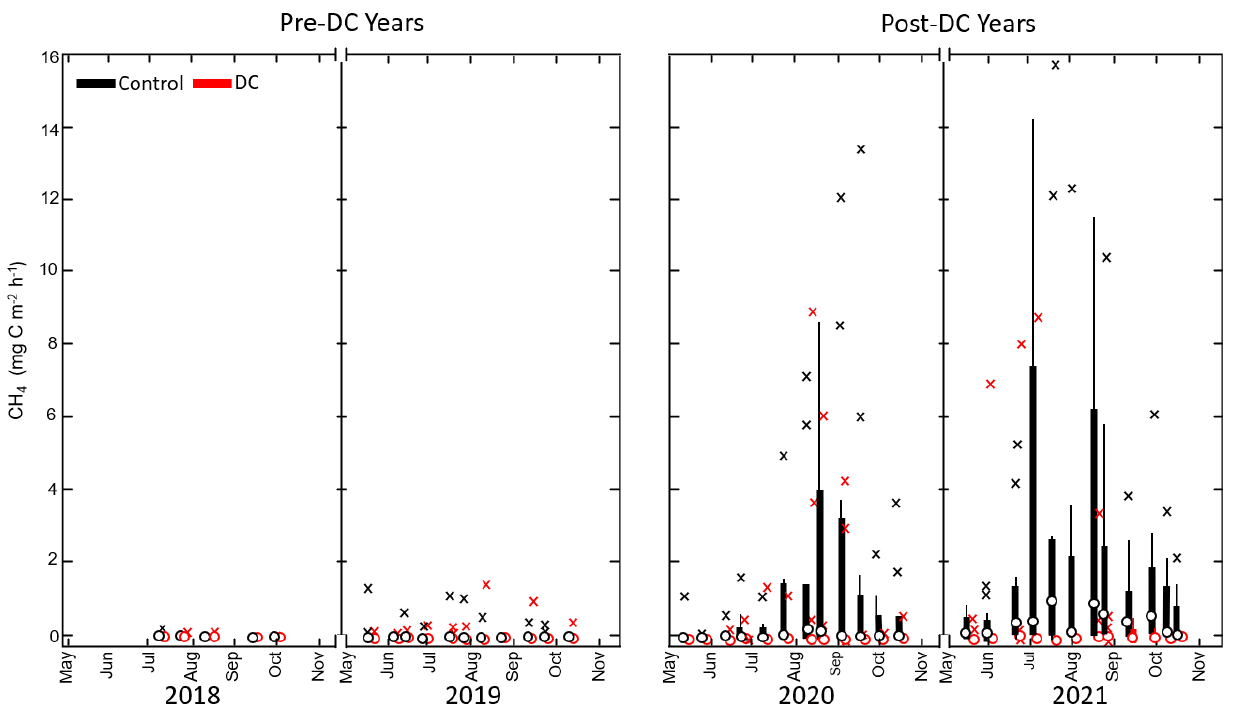
Figure 6. Seasonal variation of methane (CH 4 ) fluxes in control and ditch cleaning (DC) clear-cut areas during pre-DC (2018/19) and post-DC periods (2020/21). Negative values denote uptake. The circles denote sample ( n = 12) medians, whilst the bottom and top edges of the thick bar indicate the 25th and 75th percentiles. The vertical line denotes the range excluding outliers (crosses), which are defined as the values more than 1.5 interquartile range away from the top or bottom of the line. Data shown represent the means across all distances from ditches.